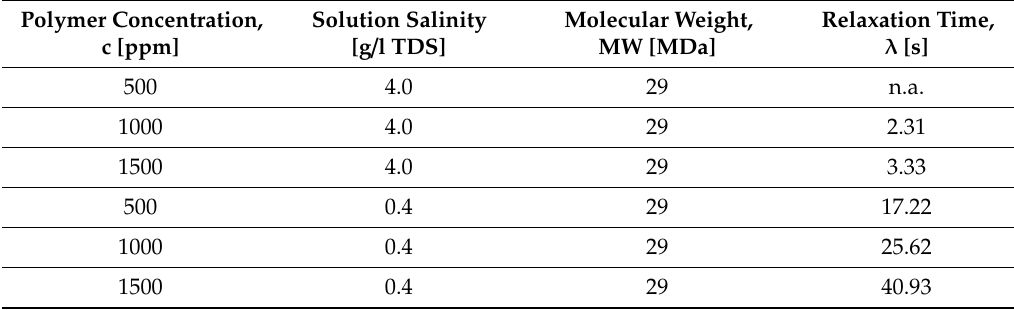
Figure 18. Apparent viscosity measured during micromodel flooding plotted against shear rate. Yellow triangles mark the onset of the transitional flow-regime and blue triangles the onset of elastic turbulence. [69]. Table 2. Relaxation times of HPAM polymers with different solution salinity and polymer concentrations [69].